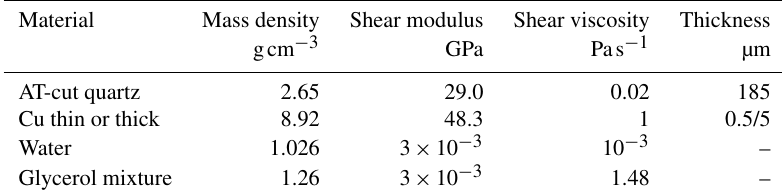
Figure 4. Admittance amplitude vs. frequency after removing the floor signal at fundamental resonance and anti-resonance. Considered material systems: quartz plate with thin Cu layer and water half-space (red curve) and quartz plate with thick Cu layer and glycerol mixture half-space (blue curve). Table 1. The used data of studied exemplary material